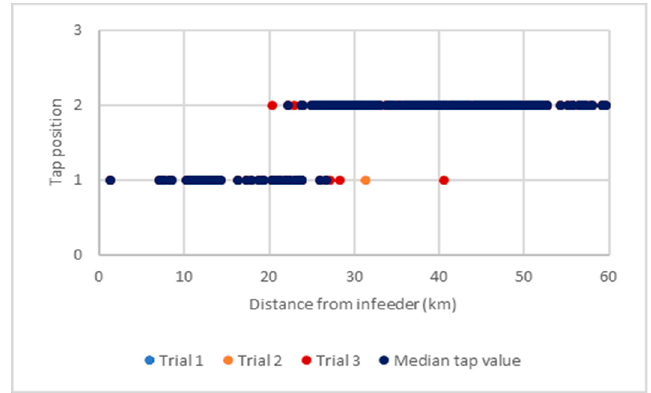
Figure 13. Transformer tap setting against transformer distance from the infeeder for Case 2.2.